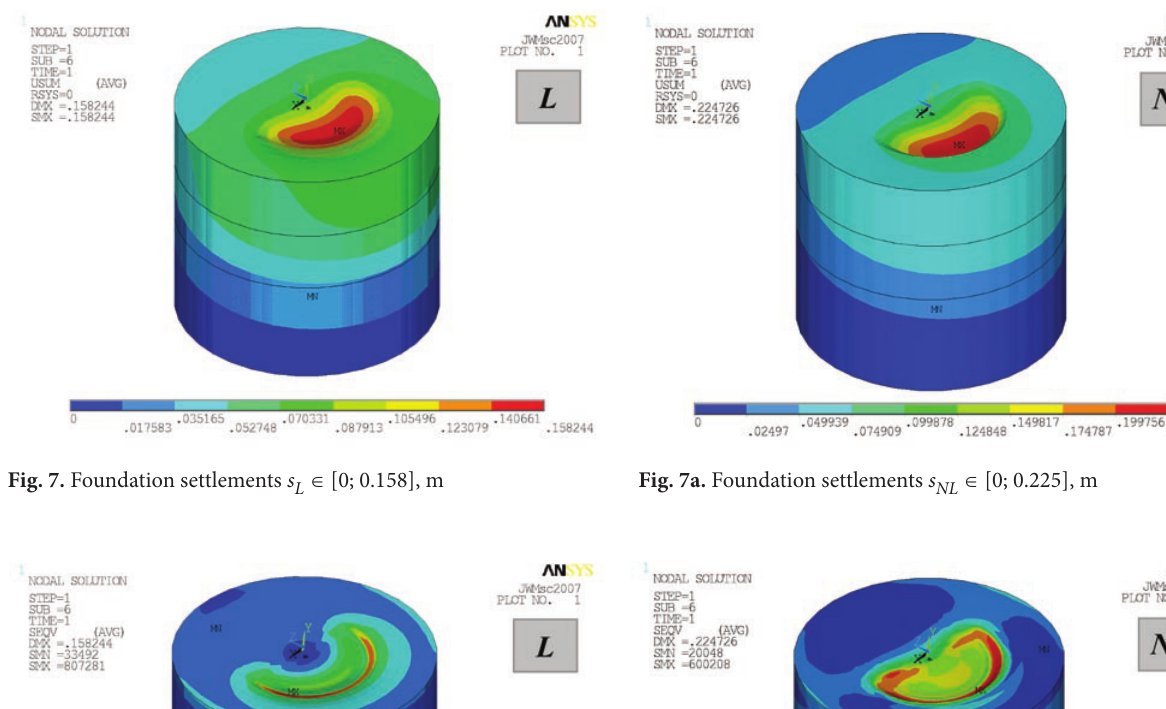
Fig. 8a. Stress intensity contours according to von Mises in the layered foundation f H-M , NL ( σ ) ∈ [20.048; 600.208], kPa